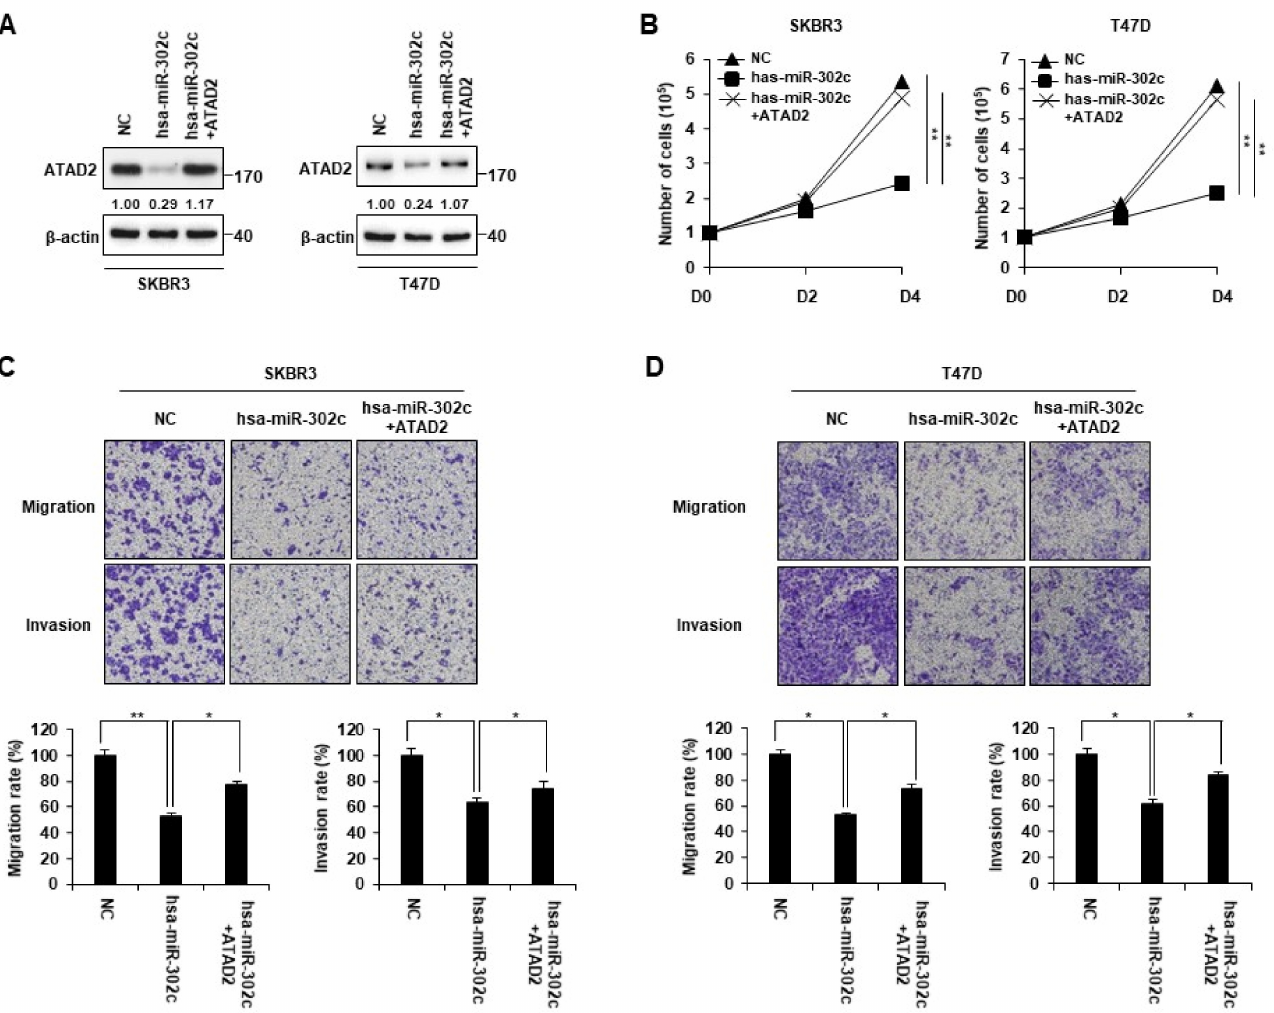
Figure 5. Restoration of ATAD2 expression rescues the miR-302c-mediated inhibition of breast cancer cell proliferation, migration, and invasion. hsa-miR-302c mimic was transfected with or without HA-tagged ATAD2 into SKBR3 or T47D cells. ( A ) The protein expression of ATAD2 in indicated cells was assessed via Western blot analysis. β -actin was used as a loading control. ( B ) The proliferation of SKBR3 and T47D were verified via cell counting after trypan blue staining at each time point. ( C , D ) hsa-miR-302c mimic was transfected with or without HA-tagged ATAD2 into ( C ) SKBR3 or ( D ) T47D cells. After 24 h transfection, transfected cells were plated into the inner chamber of the transwell without serum. Migrating and invading cells were measured using crystal violet staining as described in Materials and Methods. Graphs represent the mean of three independent